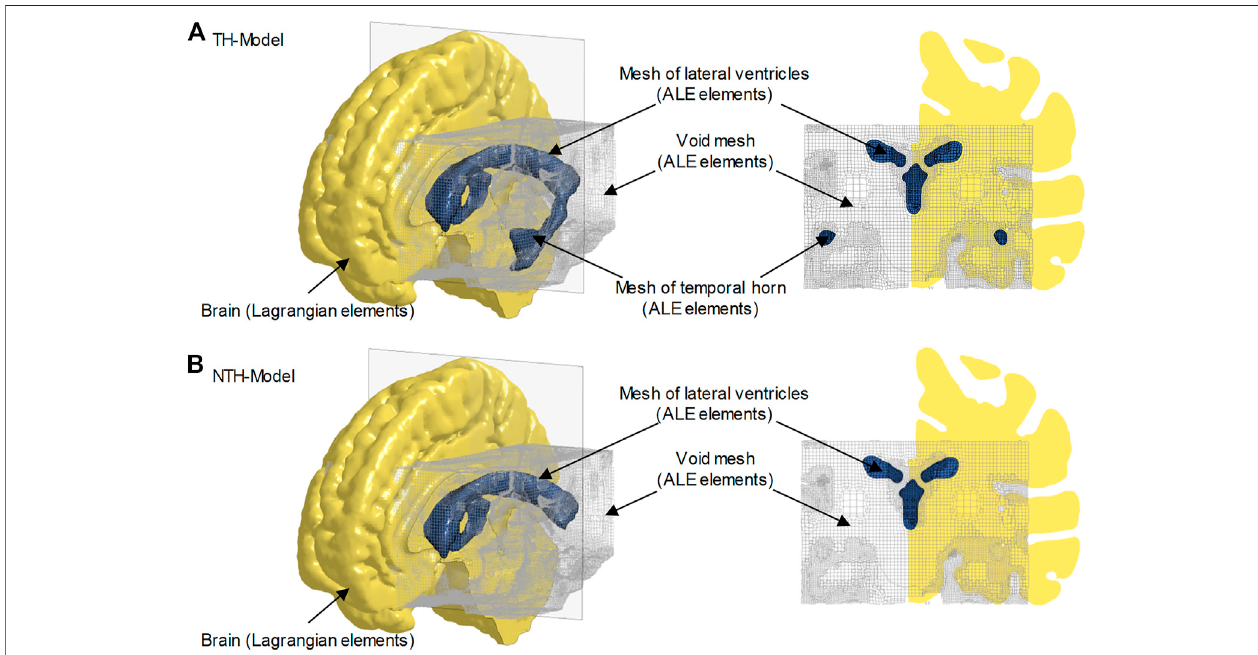
FIGURE2| Brain-ventricleinterfacesoftheTH-Model (A) andNTH-Model (B) .Foreachmodel,anisometricviewofthebrainmodel,thecerebralventricle,andvoid meshareshownontheleft.Coronalsections attheplanesindicatedintheleftsub fi guresareshown ontheright.Forbetterillustration,onlyhalfofthebrainisvisible.The cerebral ventricles are shown as blue shaded elements and the void mesh as wireframe elements. ALE: arbitrary Lagrangian-Eulerian.